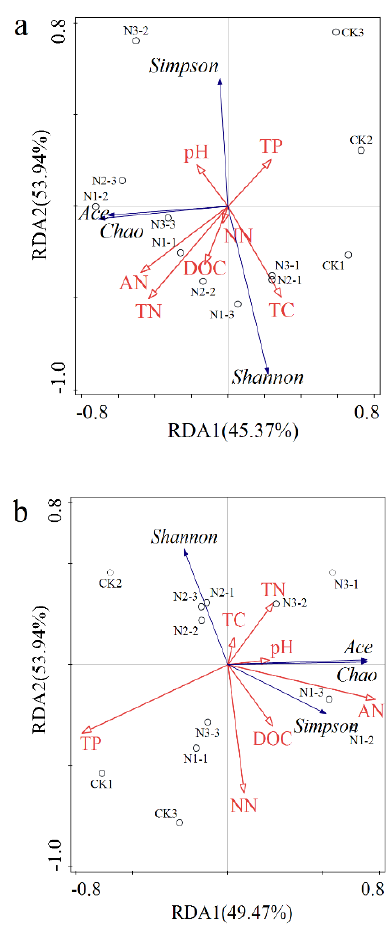
Figure 8. Redundancy analysis (RDA) of soil chemical properties and the alpha diversity indices of ( a ) bacteria and ( b ) fungi microbial communities under nitrogen addition treatments. TC: total carbon; TN: total nitrogen; TP: total phosphorus; AN: ammonium nitrogen; NN: nitrate nitrogen; DOC: dissolved organic carbon. CK1, CK2, CK3: 0 g N·m − 2 ·year − 1 ; N1-1, N1-2, N1-3: 6 g N·m − 2 ·year − 1 ; blue arrows represent soil chemical properties and the alpha diversity indices of bacteria and fungi microbial communities, respectively.